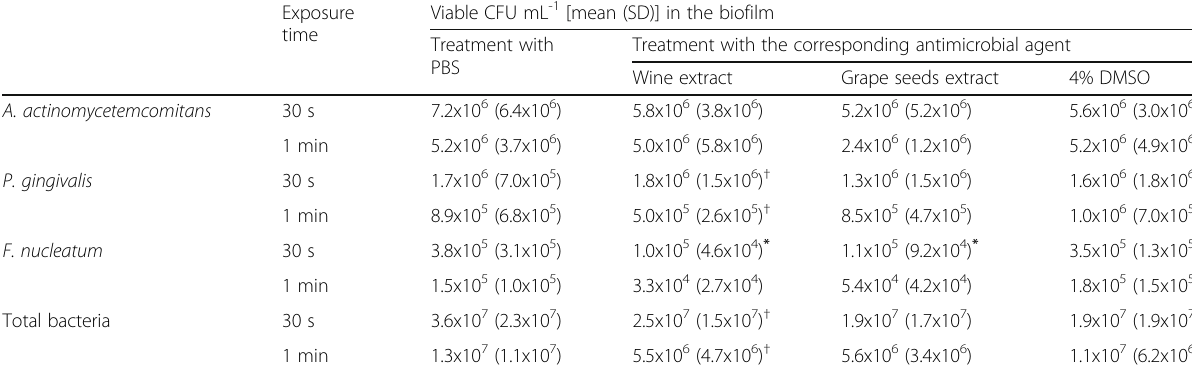
Table 3 Effect of the red wine phenolic extract (Provinols TM ), rich in anthocyanins, and the oenological extract from grape seeds (Vitaflavan ® ) on the number of viable bacteria in the in vitro multi-species biofilm [colony forming units, CFU mL -1 , obtained by quantitative real-time polymerase chain reaction (qPCR)]. Data are expressed as means ± standard deviation (SD). PBS: phosphate buffer saline; DMSO: dimethyl